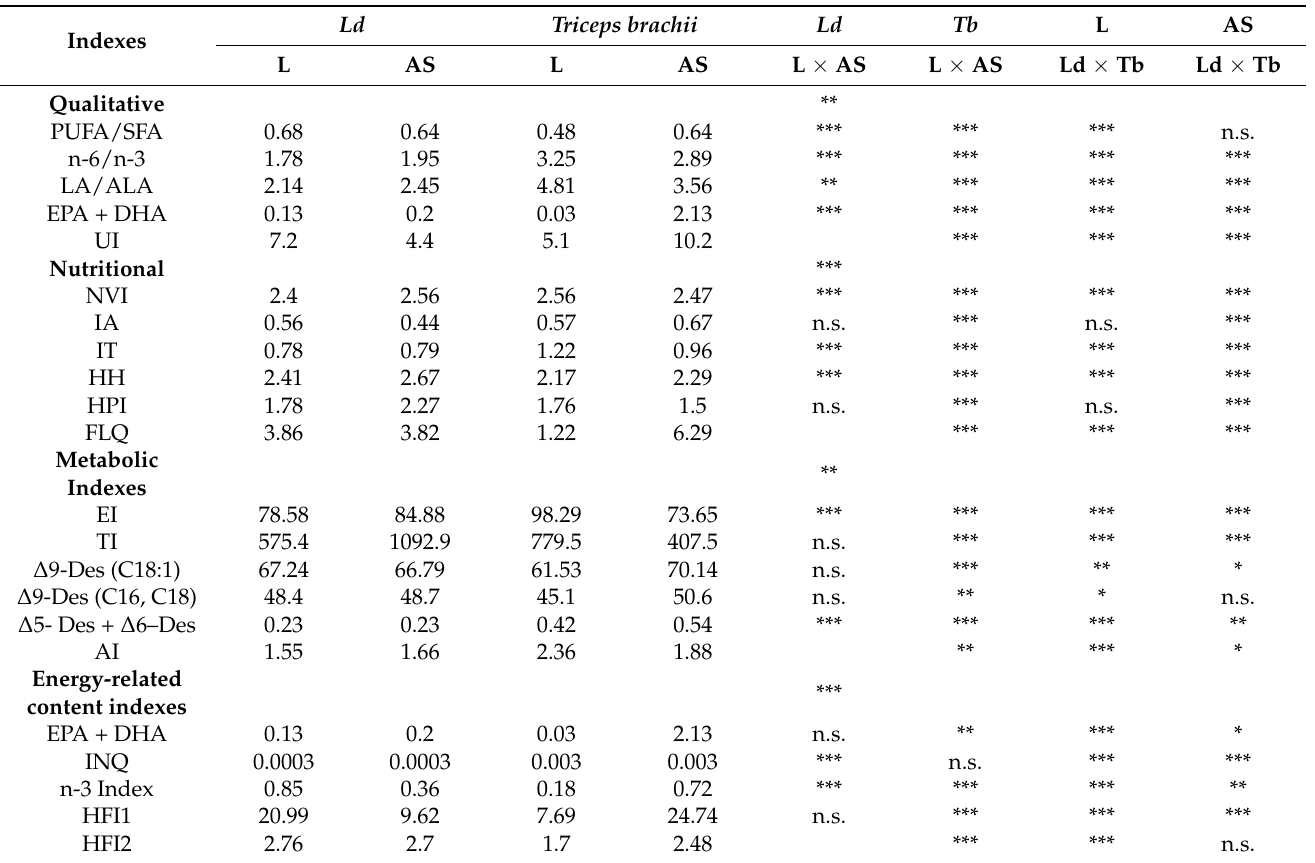
Table 3. Qualitative, nutritional, metabolic, and energy indexes for Longissimus dorsi and Triceps brachii muscles from different age groups of